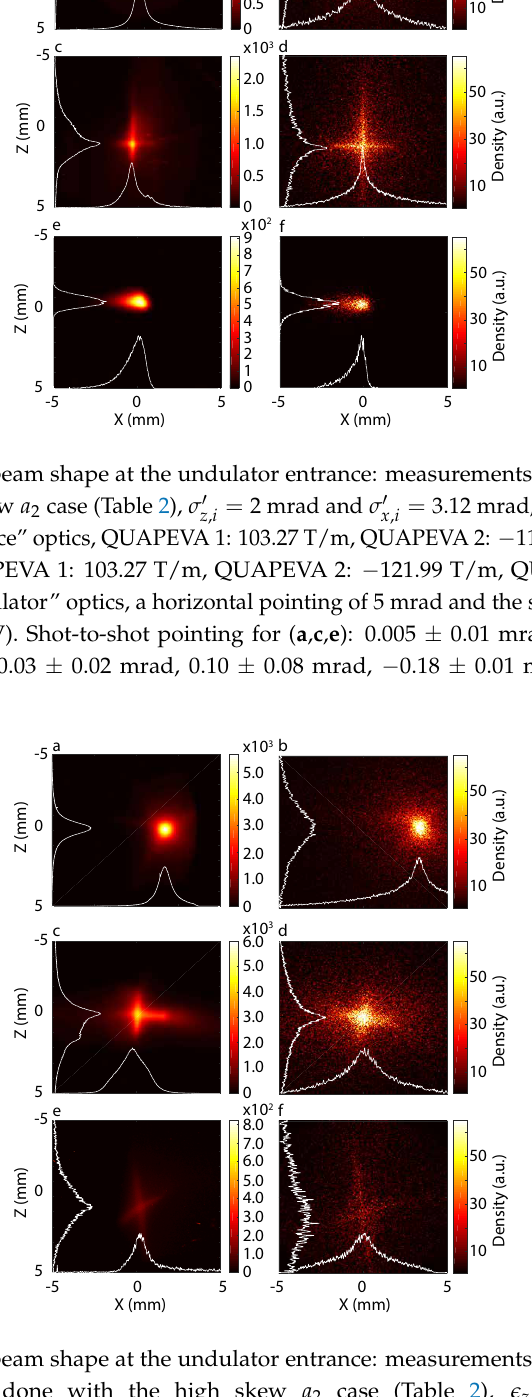
= 2.5 mrad, σ (cid:48) = 5.9 mrad z , i x , i